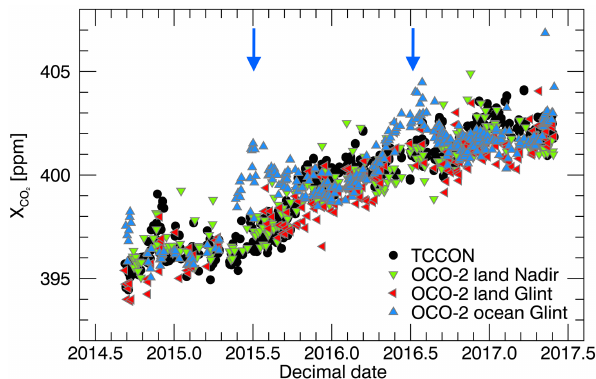
Figure 4. Comparison of X CO time series for OCO-2 version 7 and 2 TCCON, over several years at the station in Wollongong, Australia (Griffith et al., 2014b). Each OCO-2 symbol represents an overpass average. A simple geometric colocation strategy was used in which OCO-2 soundings within ± 7 . 5 ◦ latitude and ± 30 ◦ longitude of the TCCON station were retained. Large positive biases occur in the ocean glint soundings in the Southern Hemisphere winter (blue ar- rows). As seen in Fig. 19, these large biases primarily occur in the southern